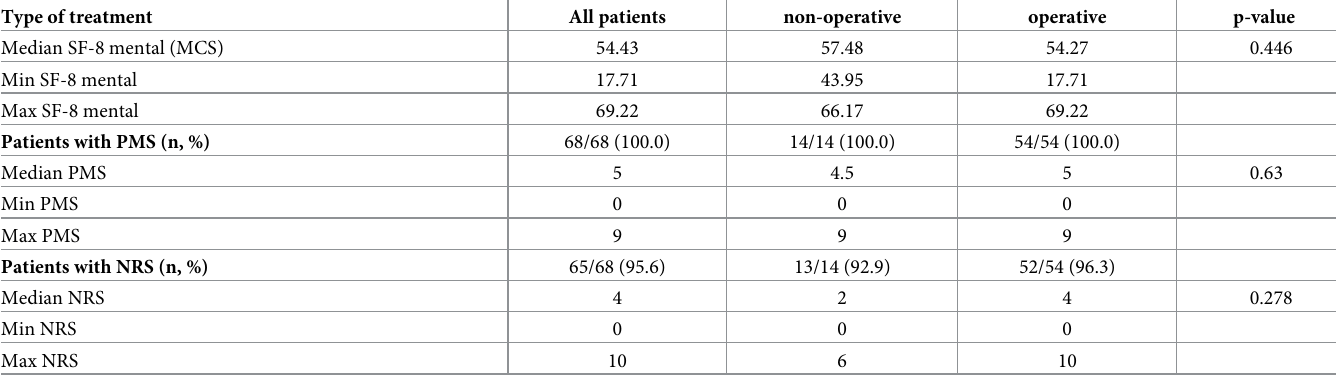
PLOS ONE | https://doi.org/10.1371/journal.pone.0253408 July 9,